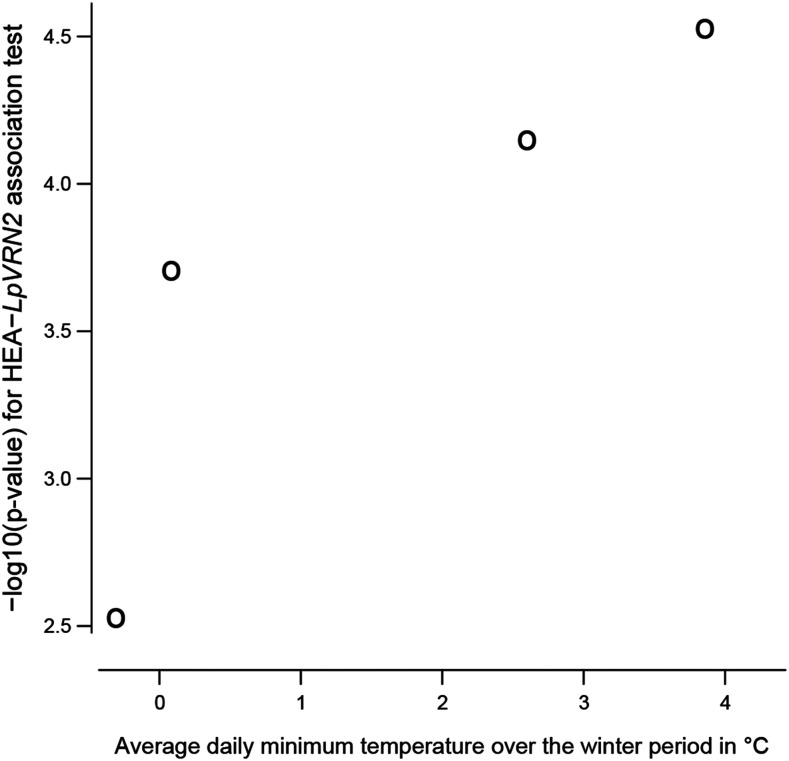
Scatterplot of the significance (-log10(pvalue)) of the association test between heading date measured in different environments and a SNP marker (position 39260 in scaffold 1700_ref0031287) located within the LpVRN2 vernalization response gene against the average daily minimum temperature (in °C) over the preceding winter period in the environment where heading date was recorded. Environments ranked from coldest to warmest average daily minimum temperature are the following: PO-2016, PO-2017, LU-2017, and LU-2016.